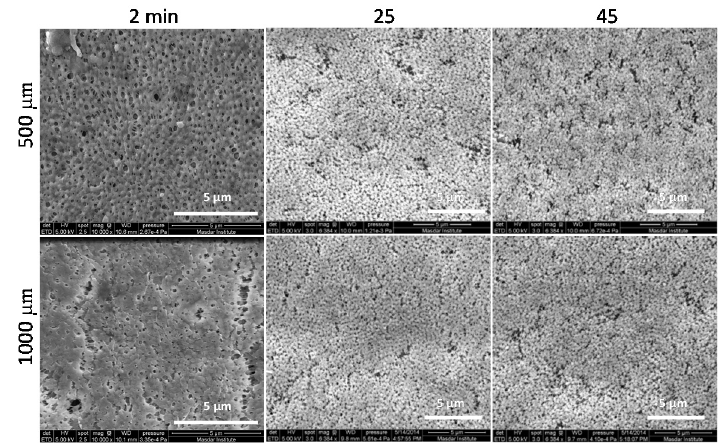
Figure 9. Surface SEM images of PVDF membranes prepared using VIPS process at different casting thicknesses and exposure times, all using 12% w / w PVDF polymer solution and under 80% RH.